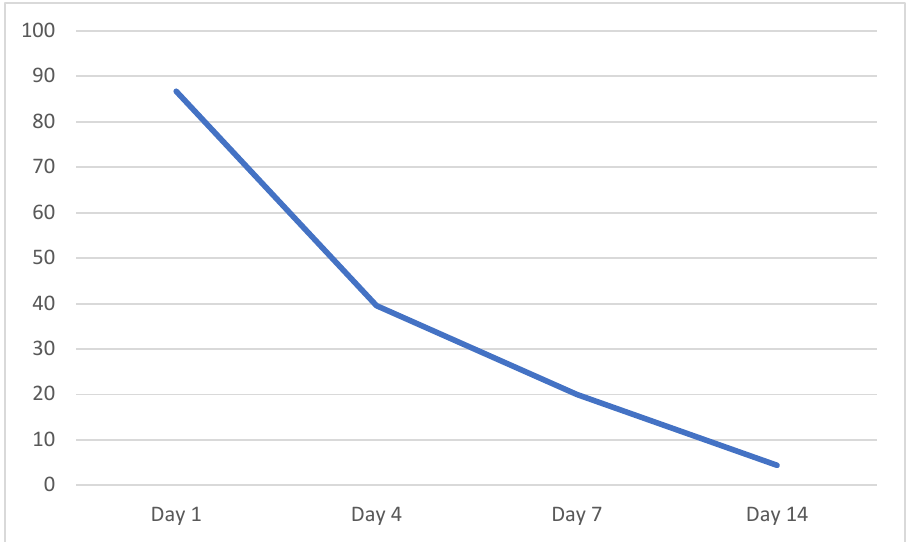
Figure 3. Percentage of eyes with visibility of cellular aggregates on AS-OCT imaging over time.